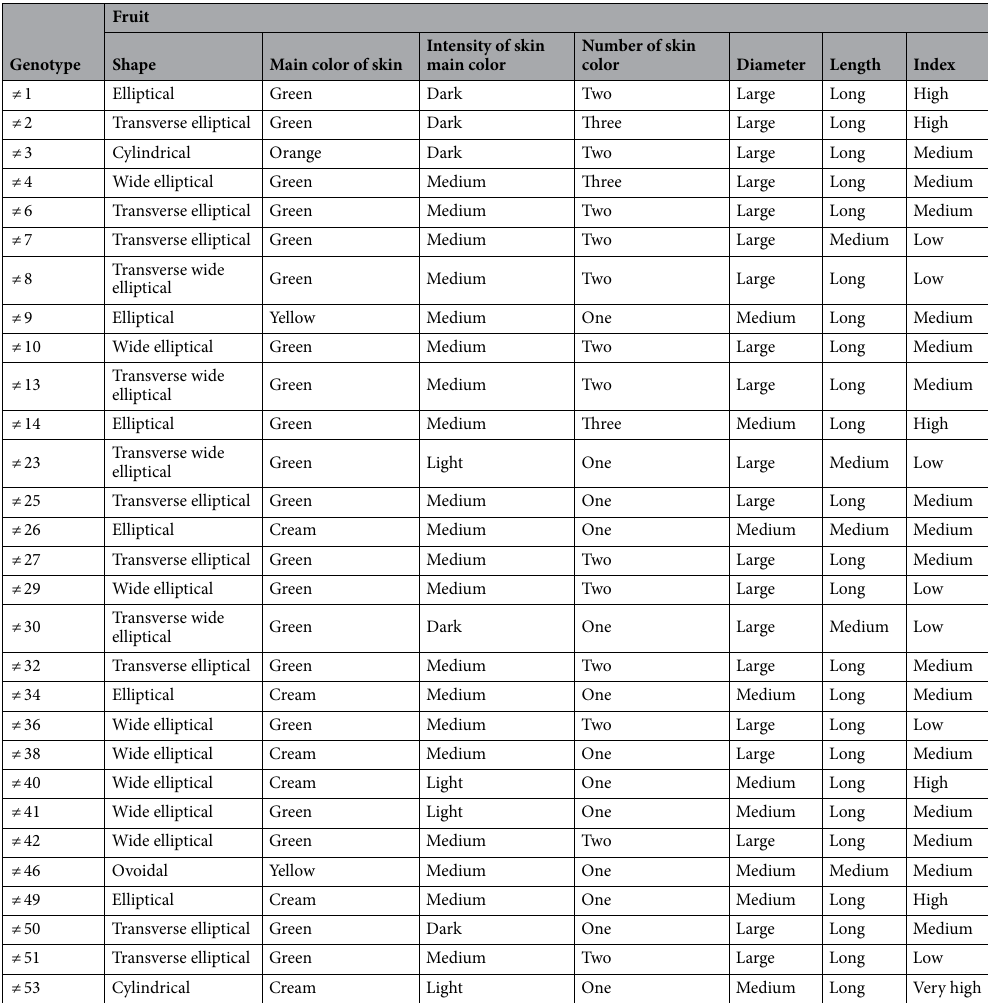
Table 5. Fruit morphological parameters of ornamental pumpkin genotypes.